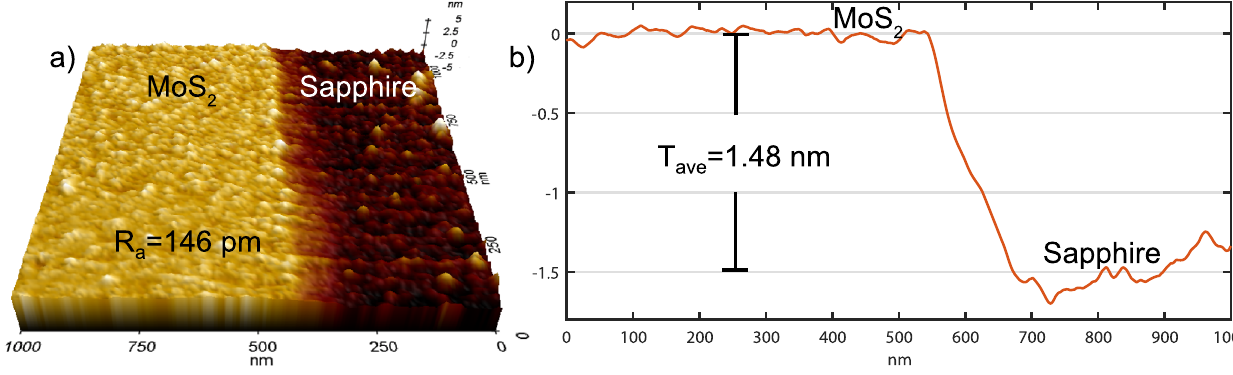
Fig. 3 AFM measurements of MoS2 bi-layer on sapphire. a 3D representation. b MoS 2 thickness pro fi dark fi eld — scanning transmission electron microscopy (HAADF-